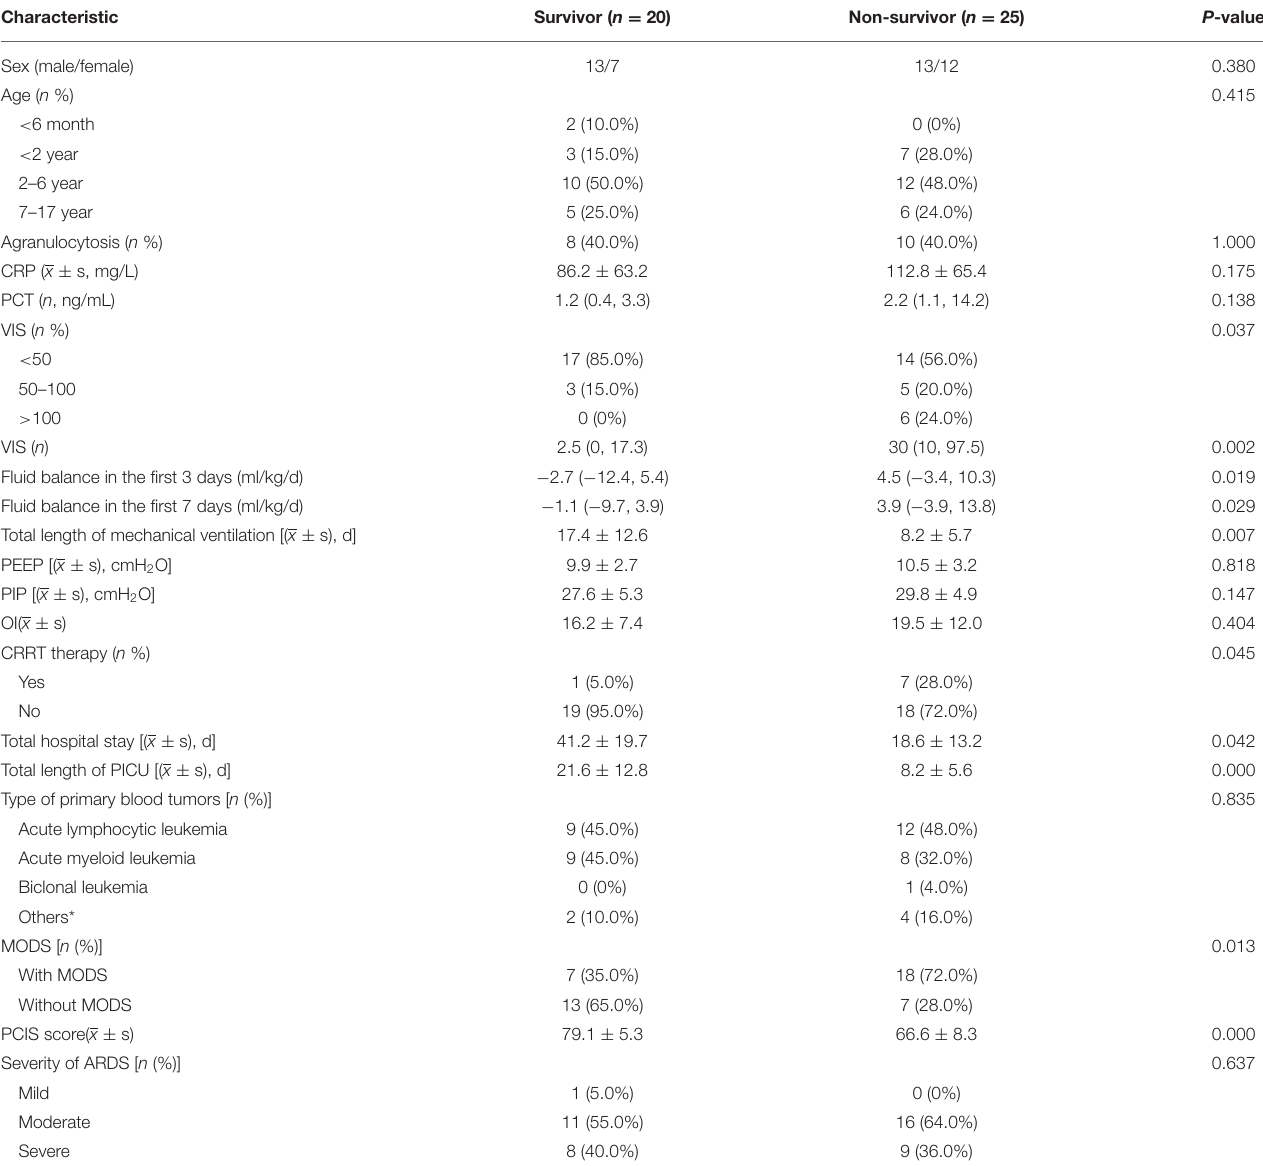
TABLE 2 | The characteristics of ARDS in children with hematologic neoplasms: survivors and non-survivors. Characteristic Survivor ( n =